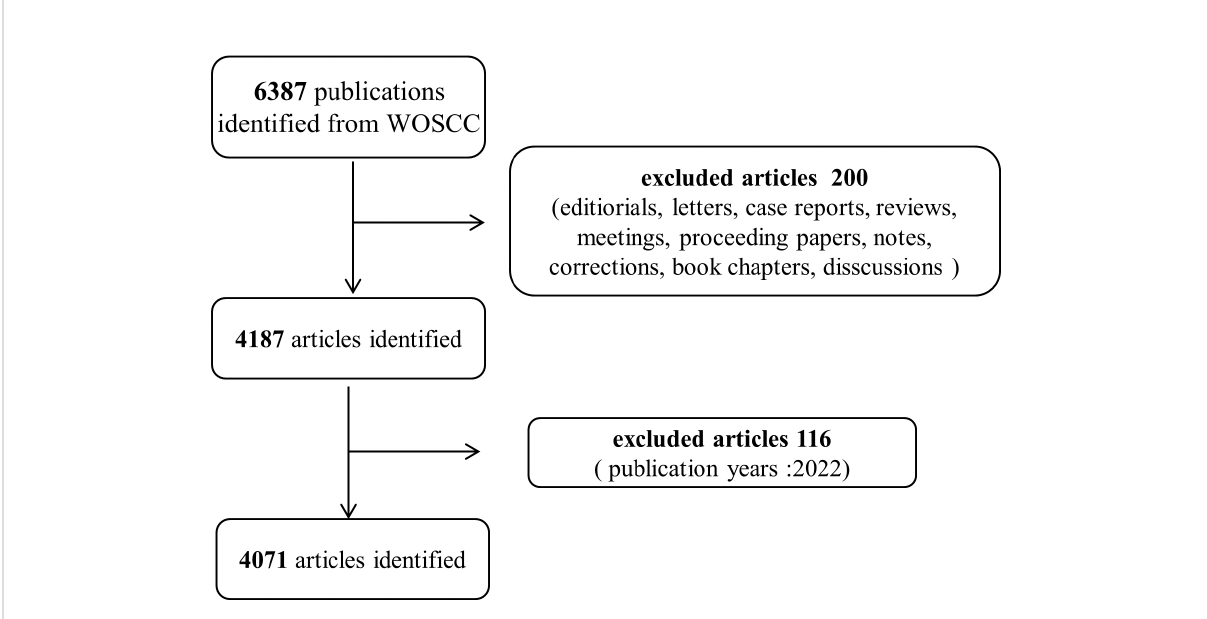
FIGURE 1 Flow diagram of literature selection and screening in this